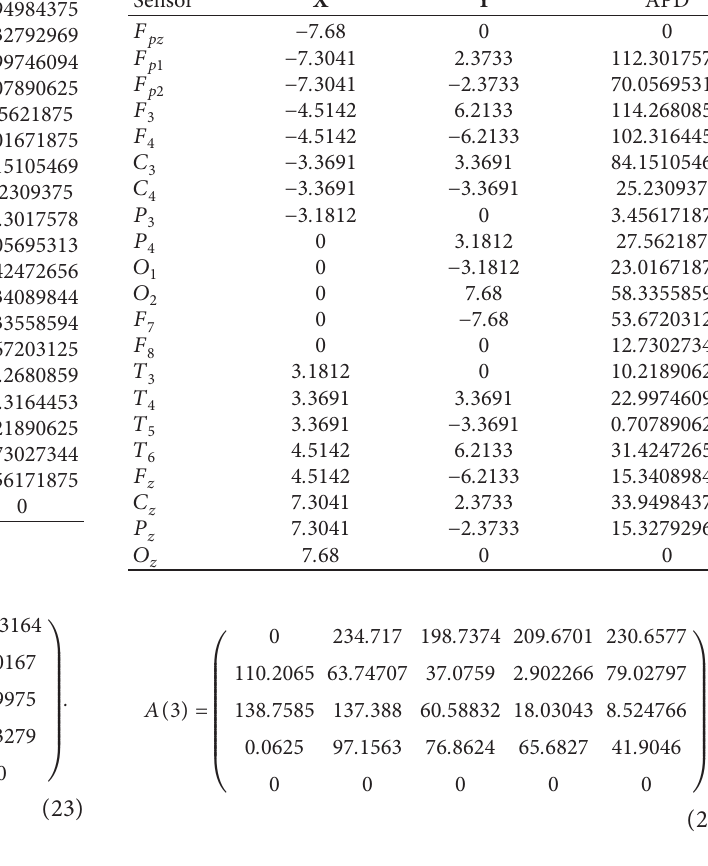
Table 5: Reordering the average potential difference (APD) at the sensor for a patient A at time t � 2